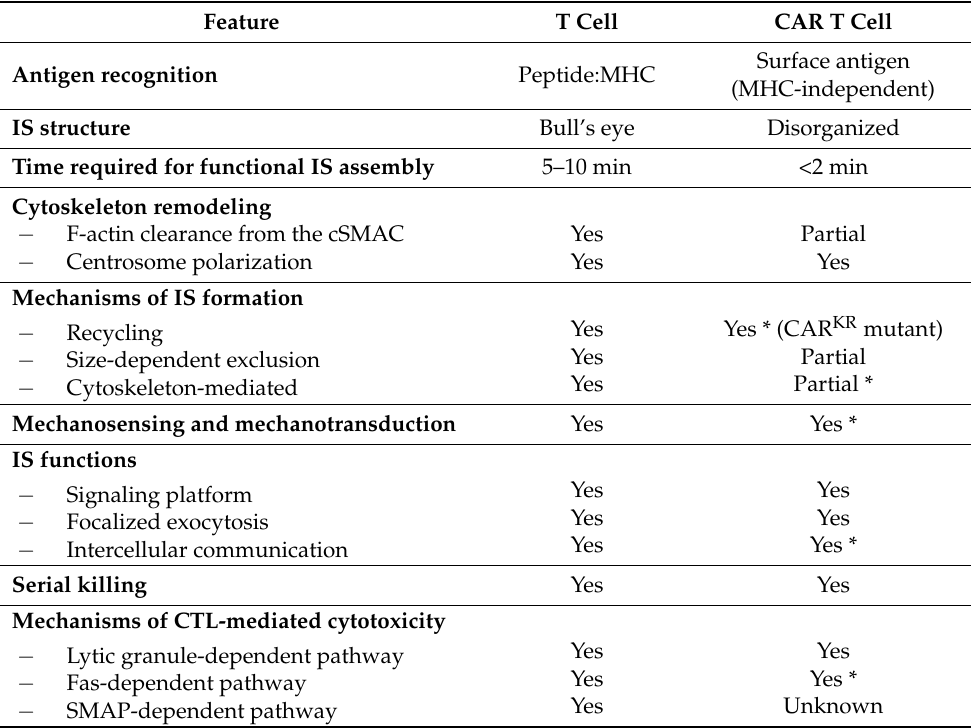
Table 1. Comparison of ISs formed by T cells and CAR T cells. Feature T